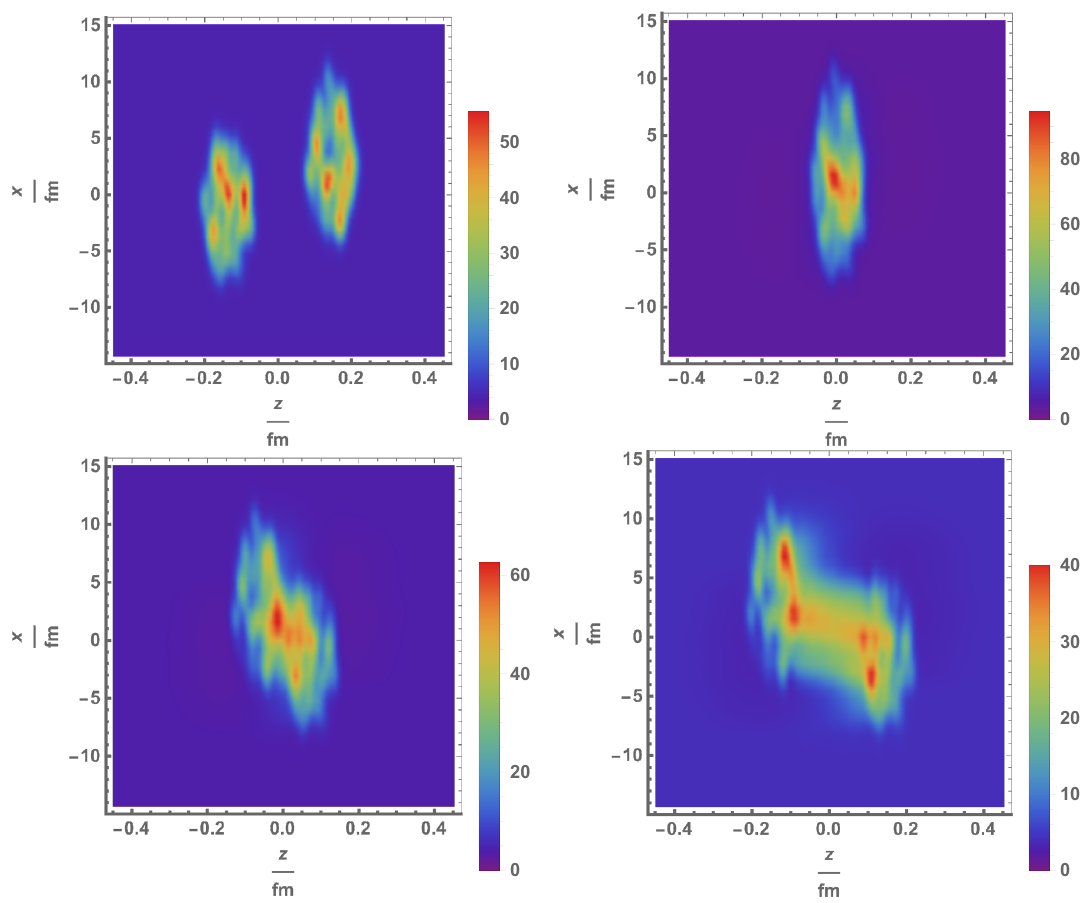
Figure 3 . The energy density T 00 in units of [ GeV 4 ] as a function of the longitudinal coordinate z and the transverse coordinate x , at y = 0 and at various times. From top left to bottom right, the y = 0 slices are evaluated at t = − 0 . 144 fm/ c , t = 0 fm/ c , t = 0 . 068 fm/ c and t = 0 . 144 fm/ c